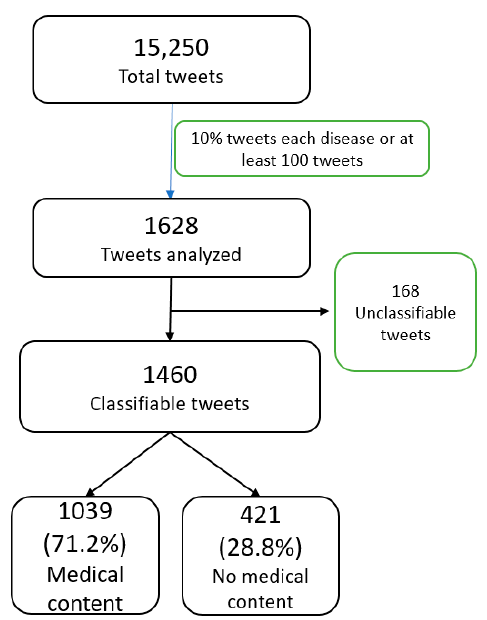
Figure A1. Figure A1. Flowchart.